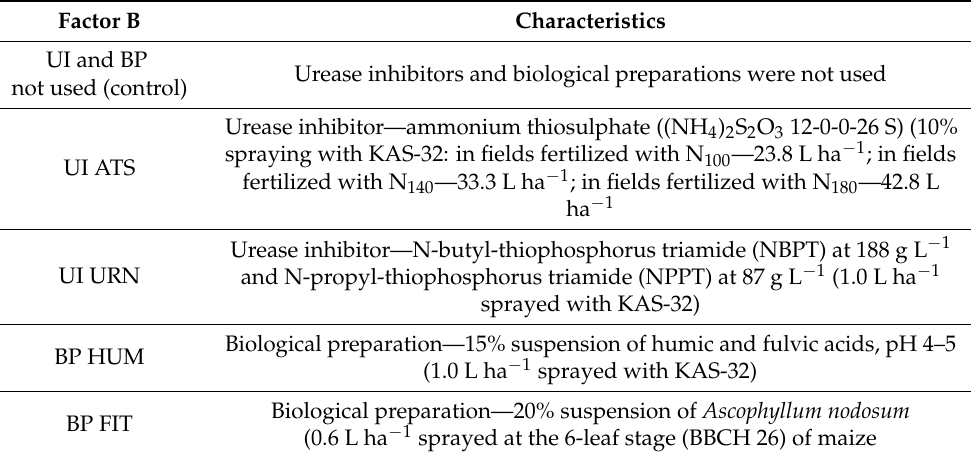
Table 2. Factor B—use of urease inhibitors (UIs) and biological preparations